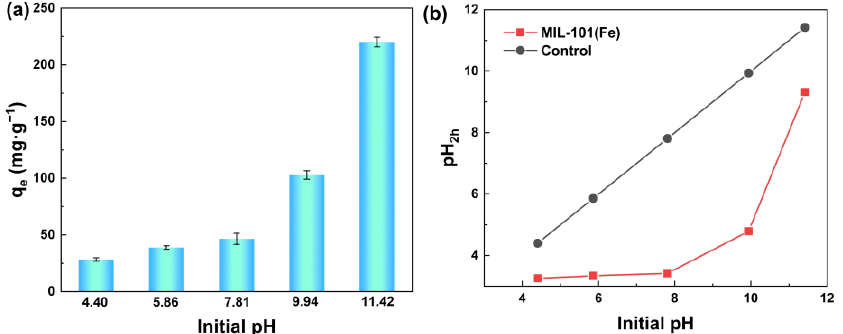
Figure 4. ( a ) Effect of initial pH value on the adsorption performance of silicic acid; ( b ) pH value changing trend with time.